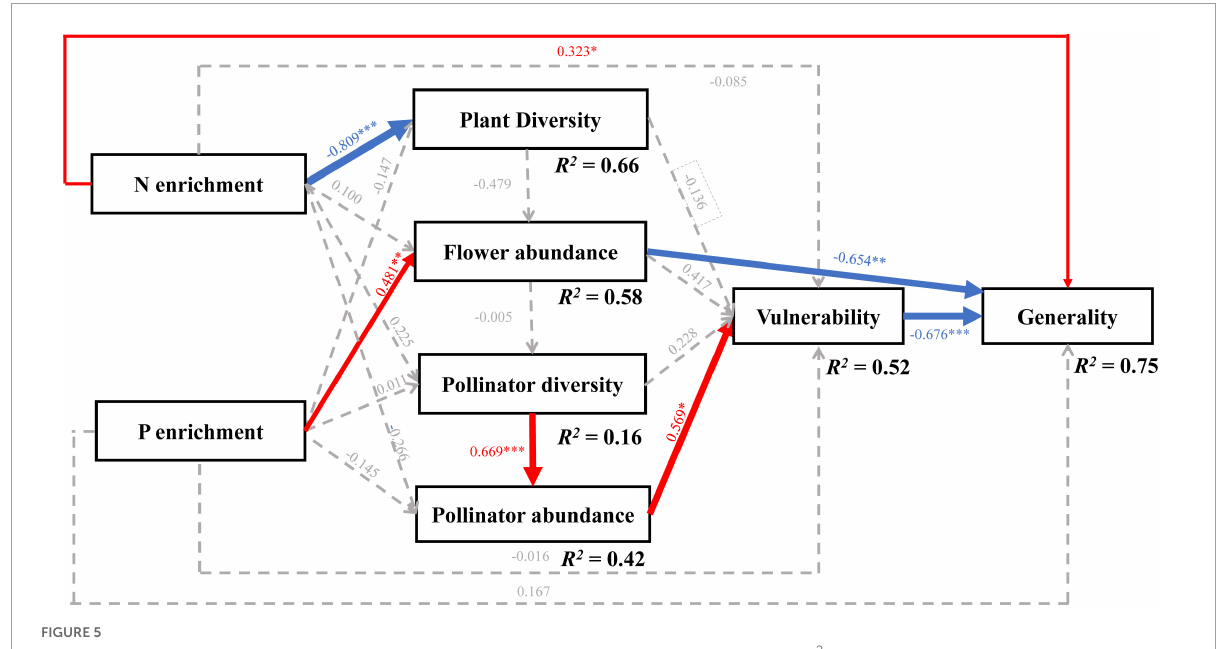
FIGURE5 The results of the final piecewise structural equation model (SEM). The final SEM fitted the data: χ 2 = 7.819, df = 14, P = 0.899, and AICc = –123.88. The numbers on the arrows indicate standardized path coefficients, and the asterisks show statistical significance: ∗∗∗ P < 0.001; ∗∗ P < 0.01; ∗ P < 0.05. Red, blue, and gray arrows indicate positive, negative, and insignificant relationships. The arrow width shows the strength of the relationship, and the marginal R 2 shows the variance, which is explained by fixed effects in the